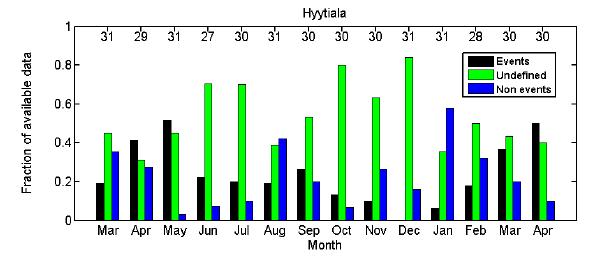
Fig. A1. The fraction of event, undefined and non-event days out of all analyzed days during each month in the year at Pallas, Finland, during April 2008–April 2009. The numbers above the figure refer to the number of days included in the analysis. (The same applies to the subsequent figures.)